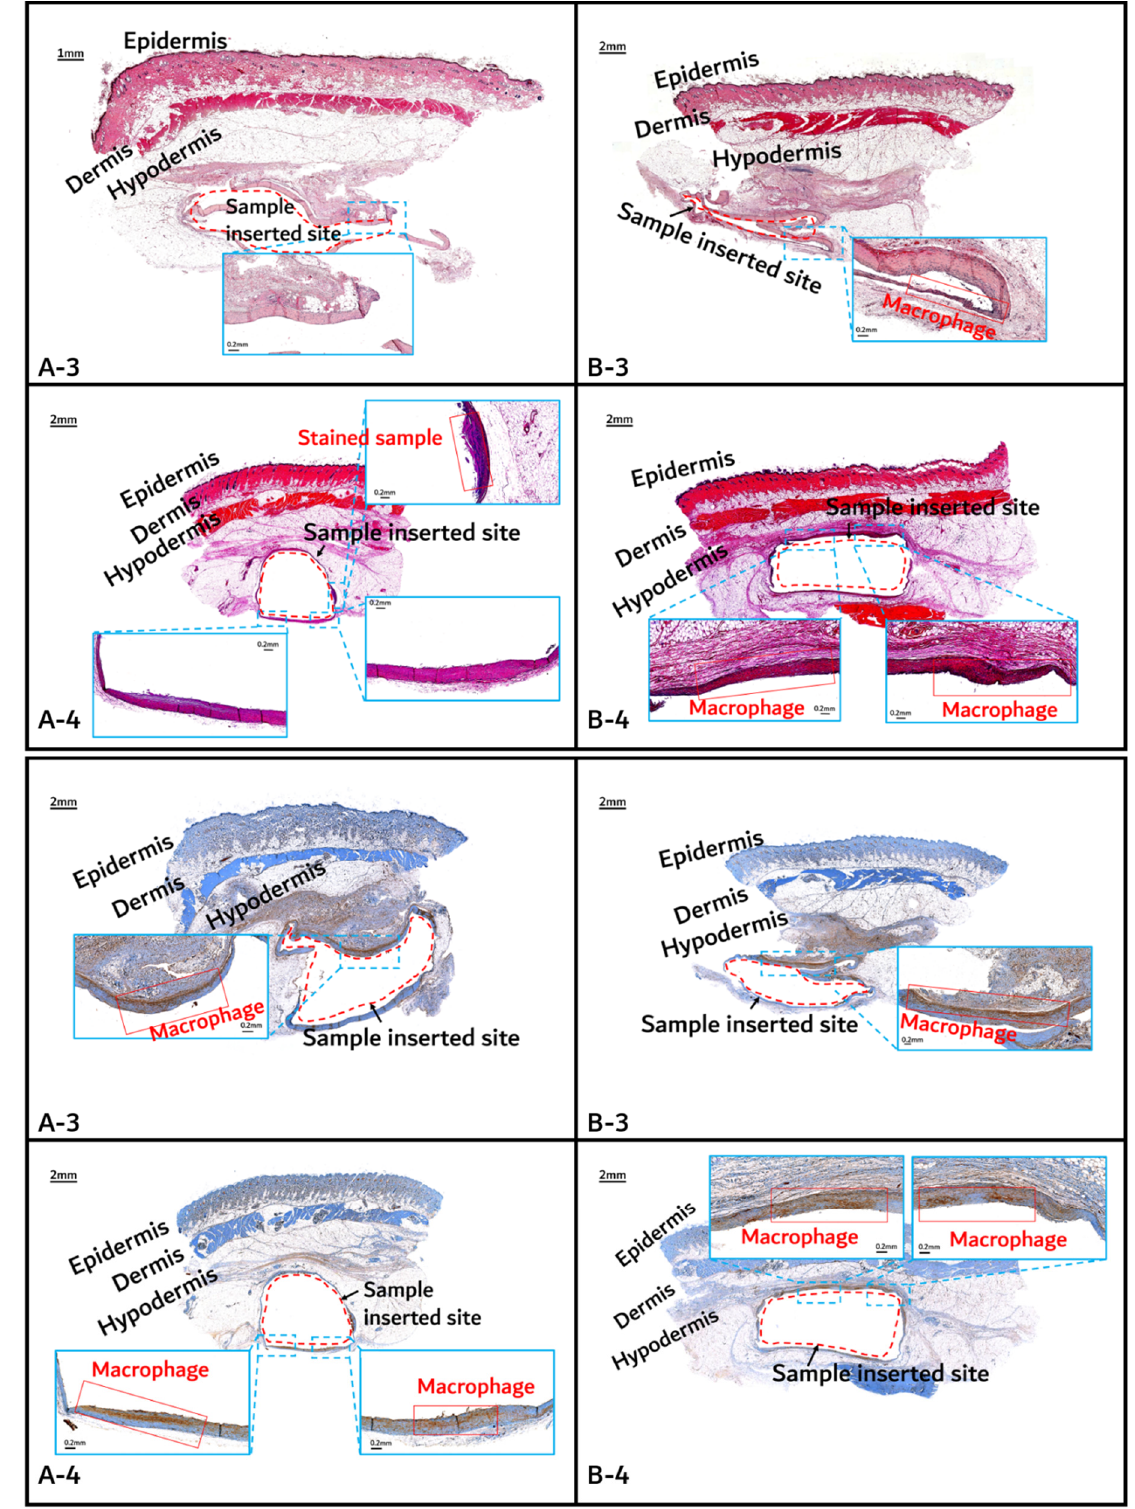
Figure 12. Histochemical analysis (upper: H&E staining, below: immunostaining) of in vivo animal degradation test. ( A-3 , 4 : tissue around a PLGA sample which 3 and 4 months after insertion, B-3 , 4 : tissue around a PGA–PLA block copolymer sample that was inserted 3 and 4 months).